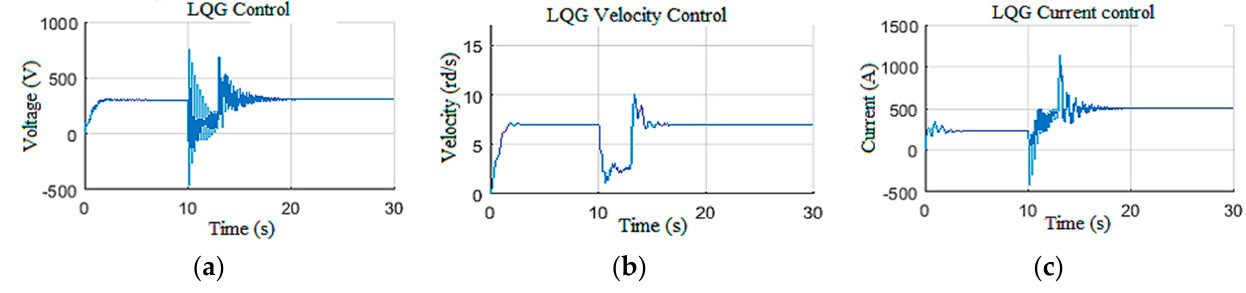
Figure 22. Controller responses: ( a ) voltage; ( b ) velocity; ( c ) current.